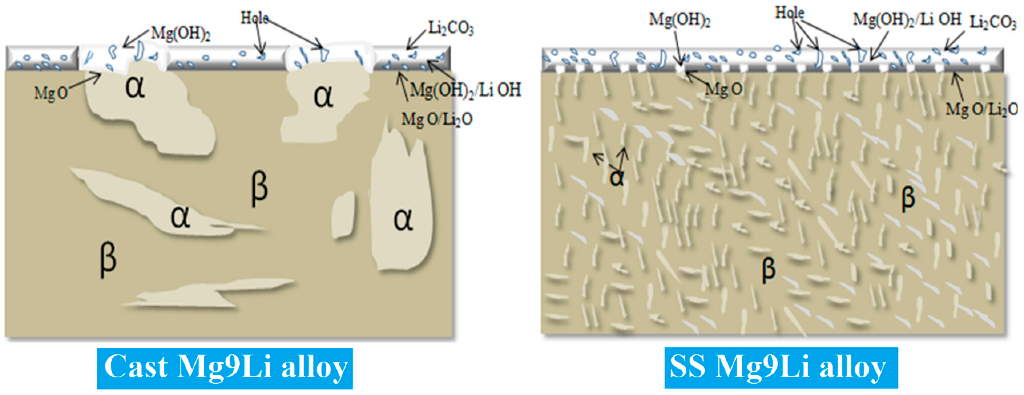
Figure 11. Illustration of surface film of the cast and SS Mg-9Li alloys.